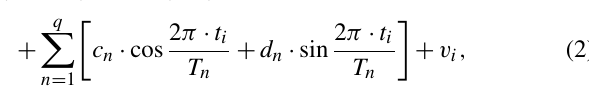
(Haines et al., 2010). The Desai (2002) model was used to eliminate the effect of ocean tide